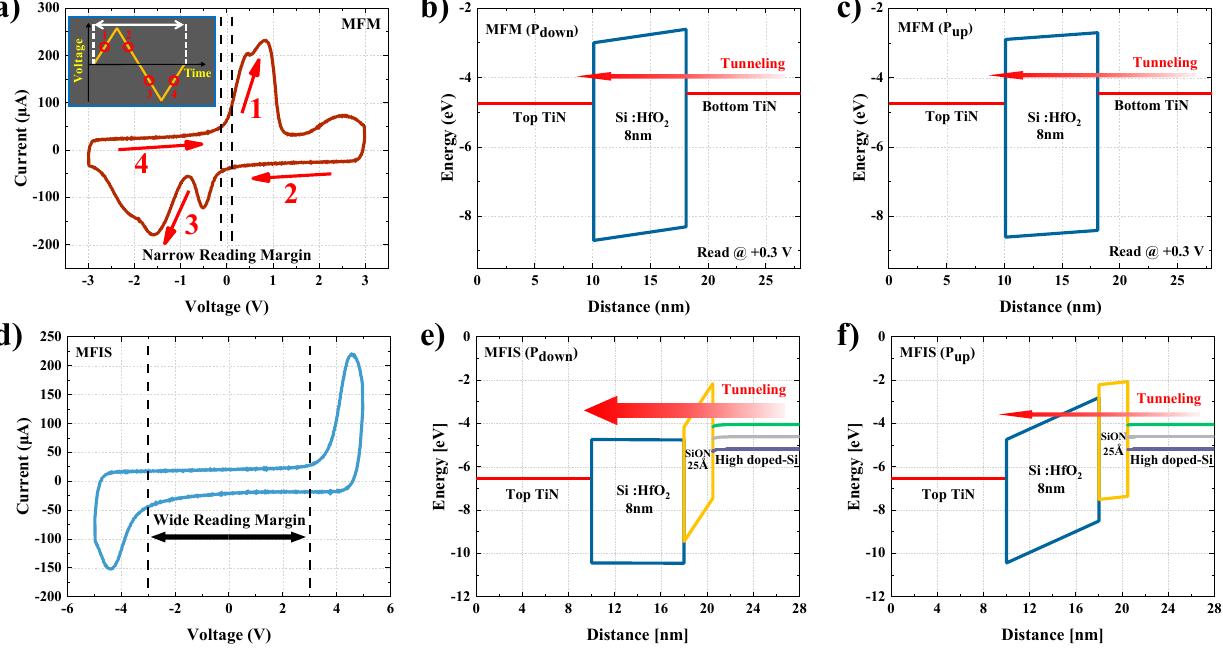
Figure 2. The current–voltage characteristics of ( a ) MFM and ( d ) MFIS FTJ devices measured using a triangular waveform; energy band diagrams for polarization directions of down and up in the ( b , c ) MFM structure and ( e , f ) MFIS structure.